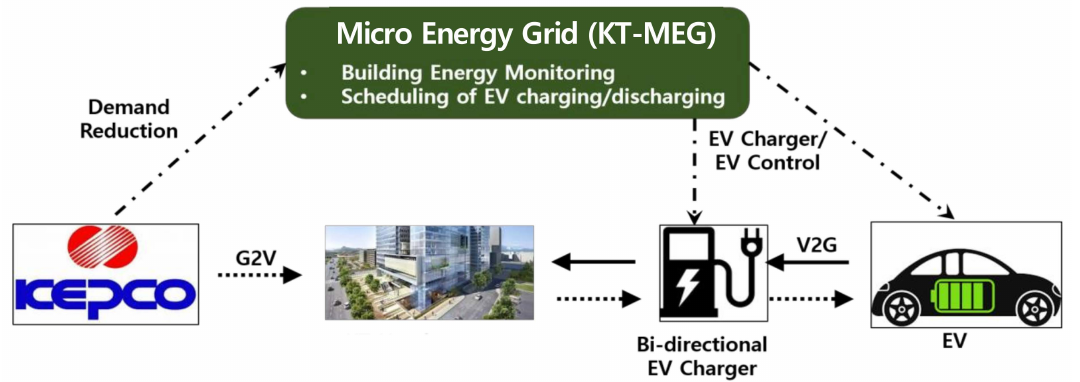
Figure 10. Electric vehicle-demand response (EV-DR) business